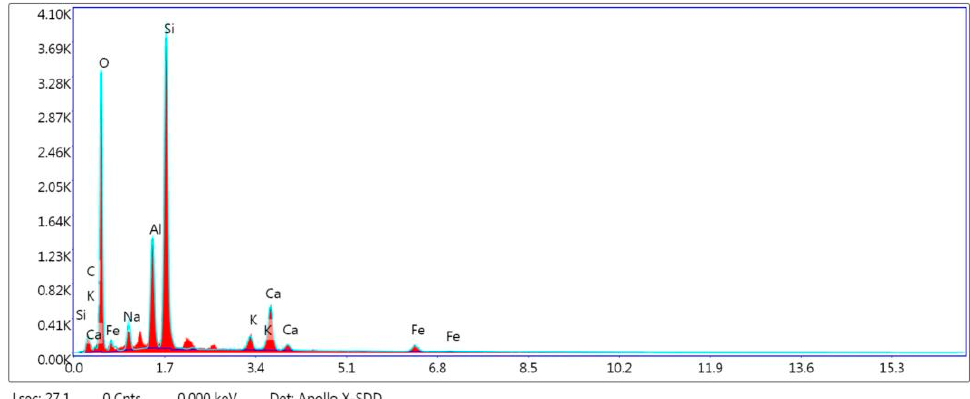
Figure 14. Energy spectrum of each element in D-0 soil sample energy spectrum area.